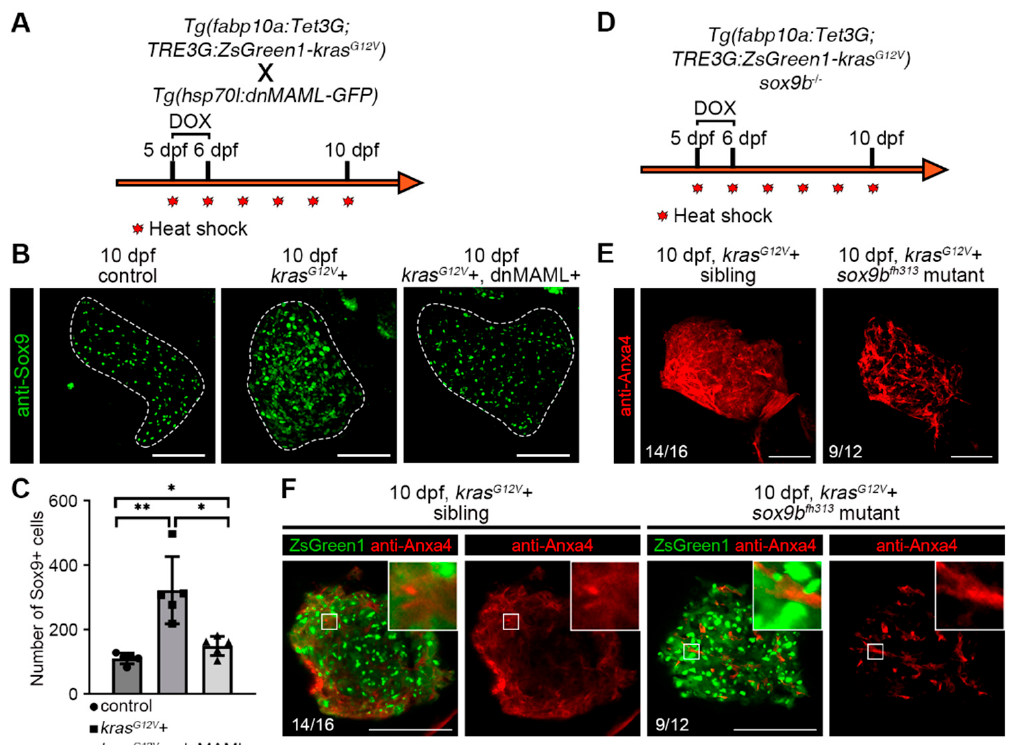
Figure 4. Hepatic Sox9 expression is upregulated after hepatocellular carcinoma induction, and the sox9b fh313 mutant suppressed hepatocyte dedifferentiation. ( A ) Tg(fabp10a:Tet3G;TRE3G:kras G12V - ZsGreen1) with Tg(Hsp70l:dnMAML-GFP) double transgenic fish line treatment strategy. ( B , C ) Sox9 antibody staining indicated the number of Sox9+ cells in the liver at 10 dpf in the DOX-induced control ( n = 5), kras G12V + ( n = 5) and kras G12V + and dnMAML+ ( n = 5) groups with statistical results. ( D ) Tg(fabp10a:Tet3G;TRE3G:kras G12V -ZsGreen1) treatment strategy in sox9b fh313 mutant. ( E ) Three-dimensional images of Anxa4 antibody staining showed biliary duct changes in the DOX-induced kras G12V + and kras G12V + sox9b fh313 mutants at 8 dpf and 10 dpf. ( F ) Monolayer images of Anxa4 antibody staining biliary duct changes in the DOX-induced kras G12V + and kras G12V + sox9b fh313 mutant at 8 dpf and 10 dpf. Asterisks show significance: *— p < 0.05; **— p < 0.01. Scale bars—100 µ m; error